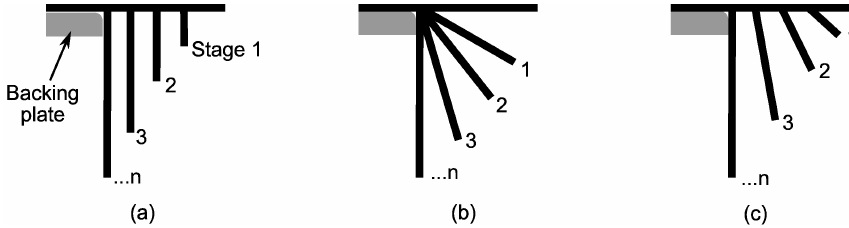
Figure 4. Schematic representation of hole-flanged sheet sections produced by SPIF using different multi-stage strategies producing successive ( a ) concentric cylinders; ( b ) conical frustums with increasing angle; and ( c ) conical frustums with increasing angle and major diameter.